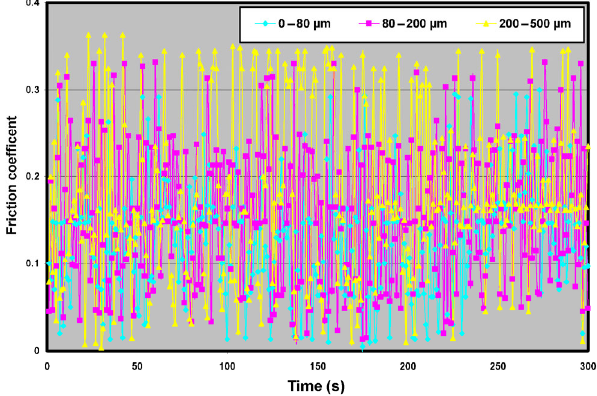
Fig. 9 Effect of sand particle size on friction for a sand concentration of 2 g/L.